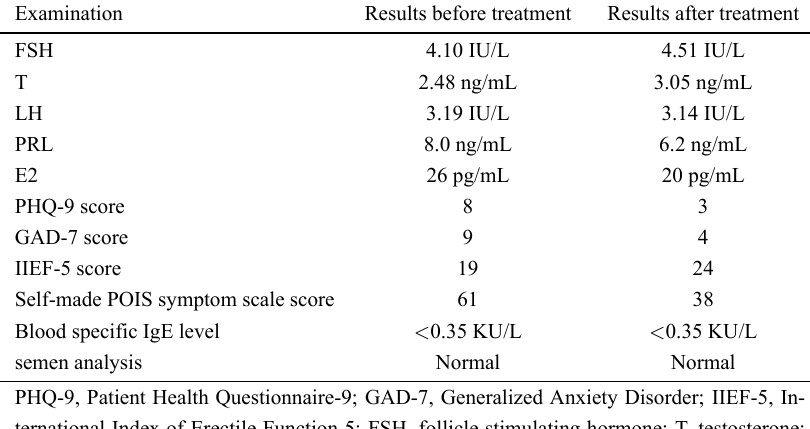
Table 3. Examination results before and after